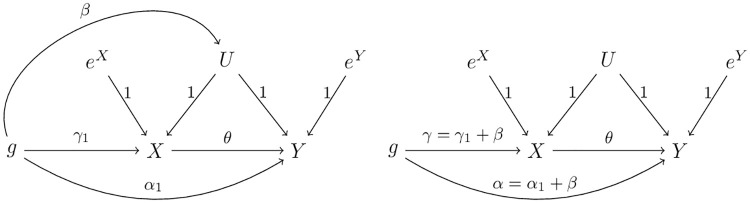
The case where the SNP/IV is directly associated with confounder U (left panel), which, by absorbing the effect of SNP → U into SNP → X and SNP → Y, leads to the case where the SNP/IV has a direct effect on Y (right panel).